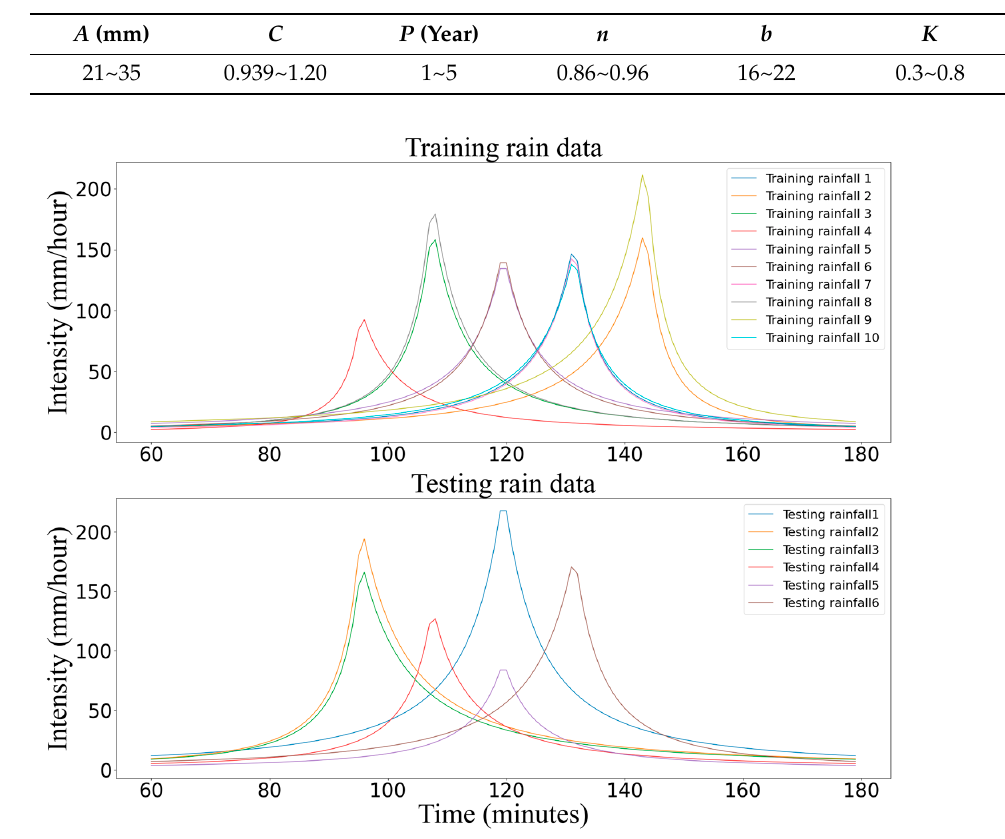
Figure 2. The rainfall data used for DRL training and testing. Table 2. The range of parameters in Equation